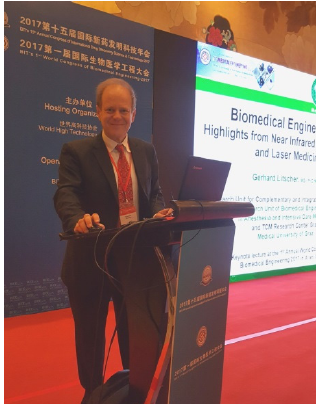
Figure 2. Professor Gerhard Litscher, Keynote Speaker of the “BIT’s 1st World Congress of Biomedical Engineering 2017” in